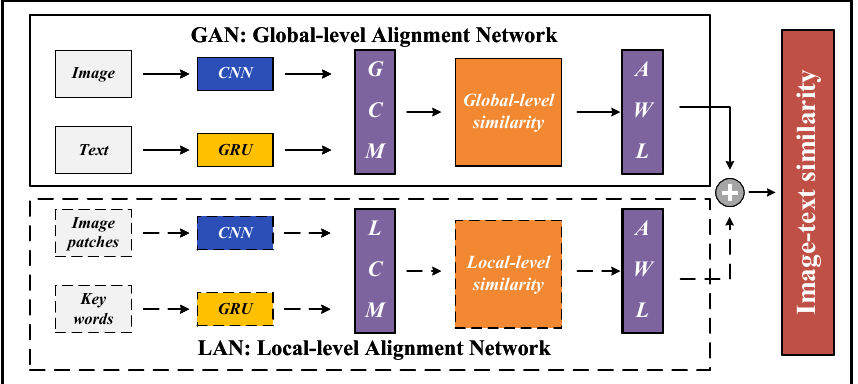
Figure 2. The pipeline diagram of the whole solution of